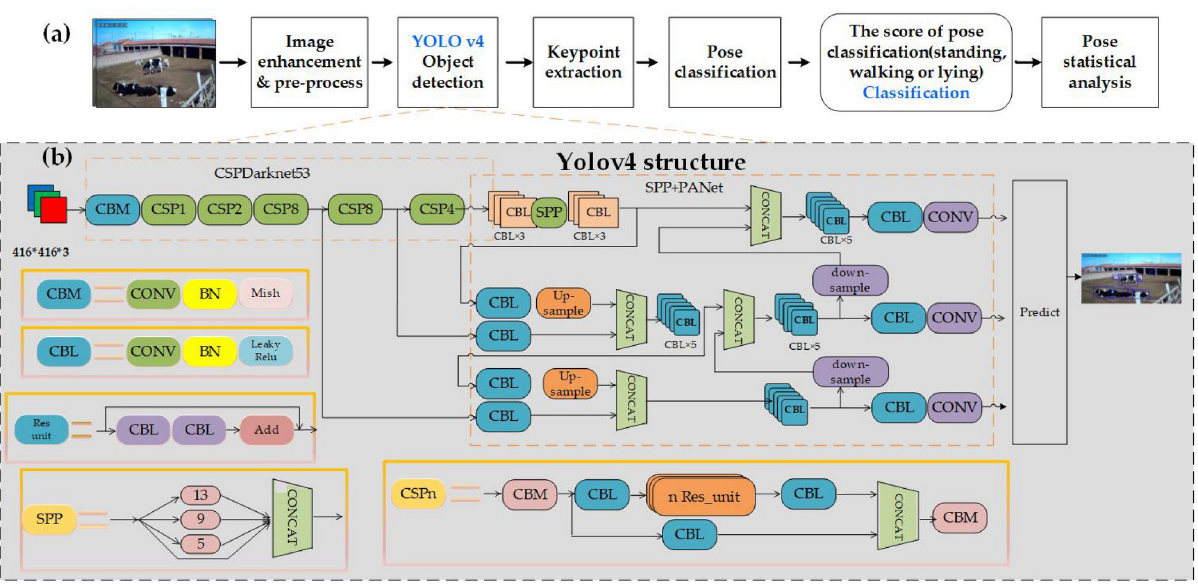
Fig 2. (a) Overview of pose analysis procedure. (b) Close-up of the multiobject detector based on YOLO v4.